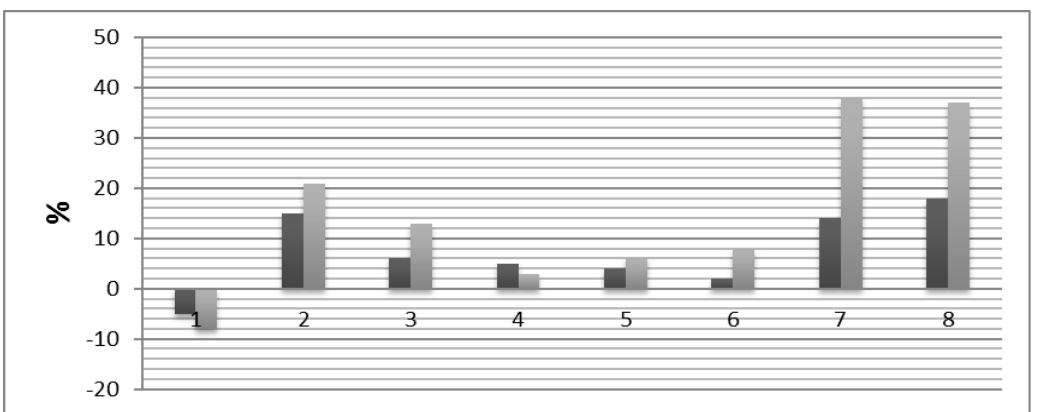
Fig. 5. Changes of pedaling bio-mechanical characteristics of elite cyclists in periods of fatigue’s overcoming and evident fatigue during speed-power oriented trainings.